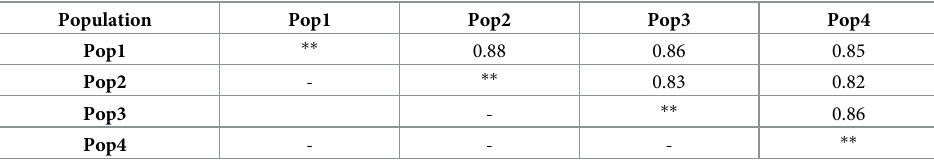
Table 6. Nei’s genetic identity among populations of wild ancient tea tree at different altitudes.